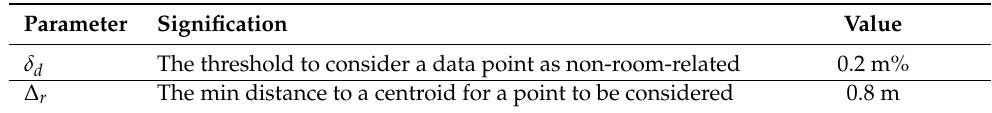
Table 3. Parameters used for Algorithm